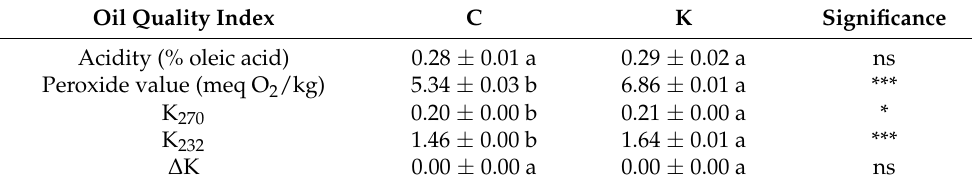
Table 3. Quality indices of analyzed oils with kaolin treatment (K) compared with control (C). Oil Quality